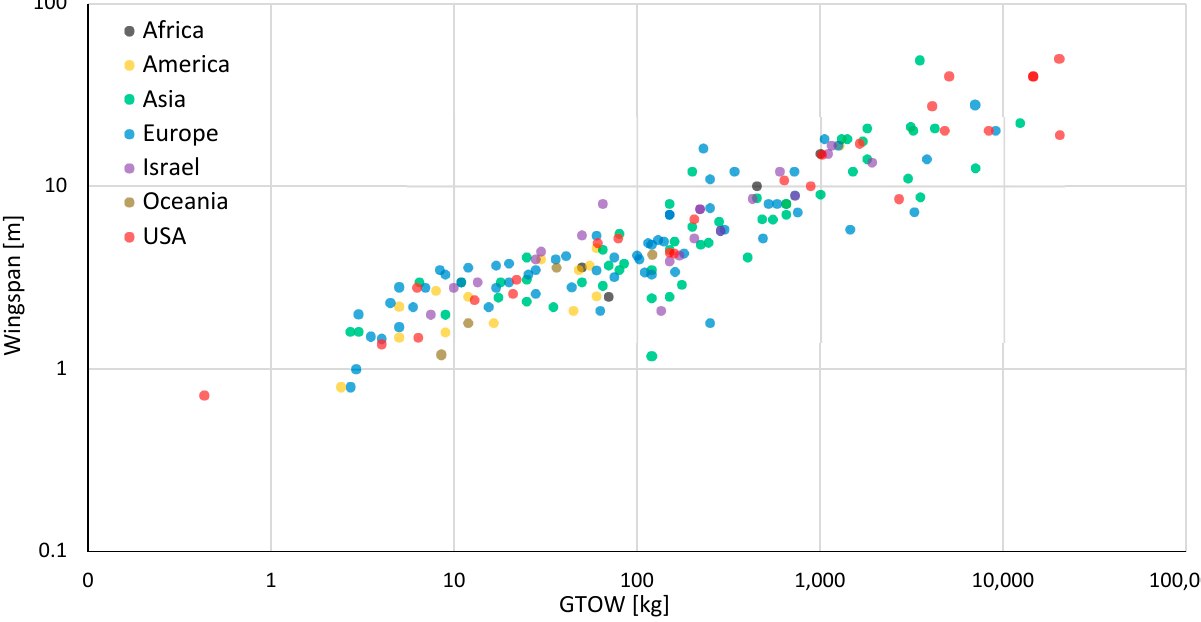
Figure 7. Wingspan as a function of GTOW with respect to region of origin.